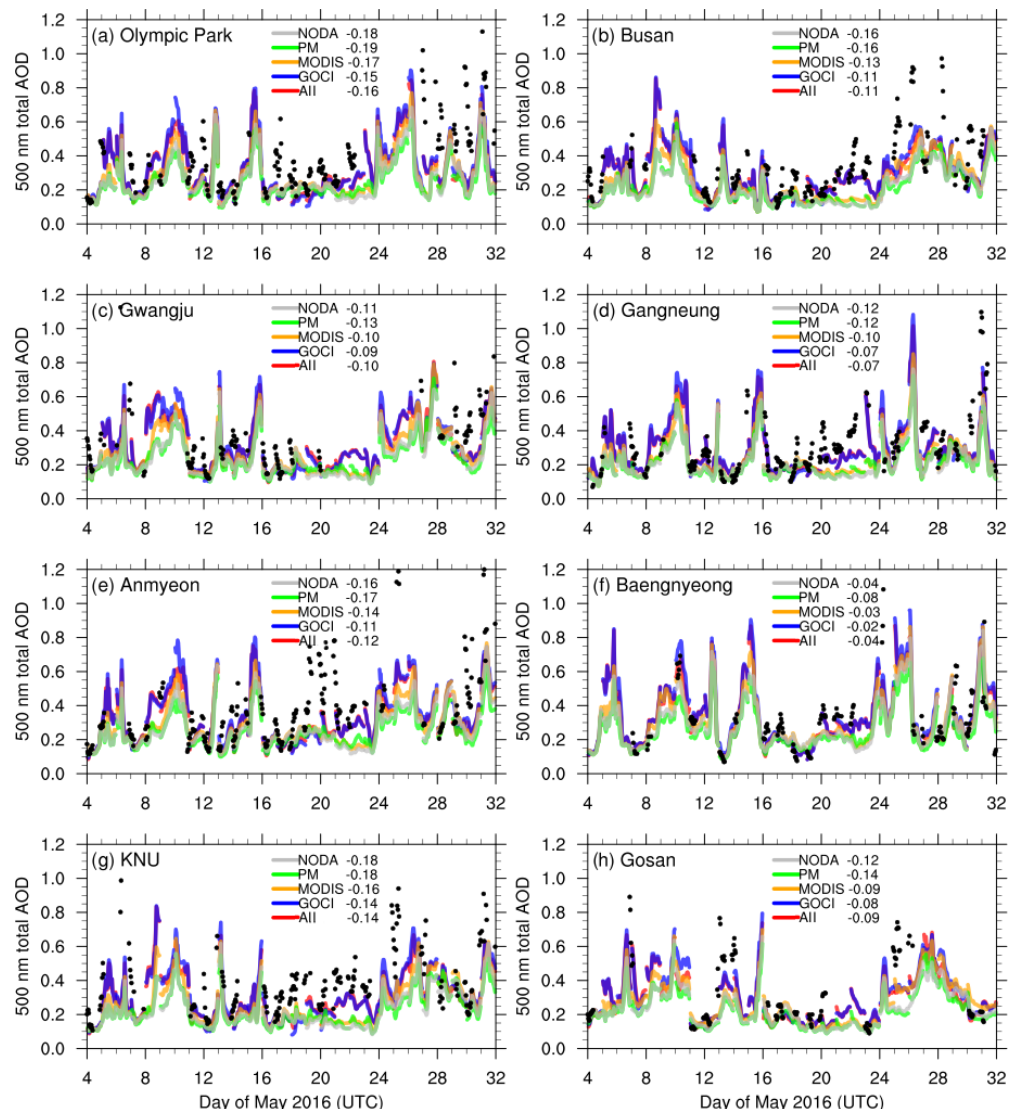
Figure 13. Hourly time series of total AOD at 500nm from 00:00UTC on 4 May to 23:00UTC on 31 May at eight different AERONET sites. Model values in different colors represent output every hour beginning at the initial time and ending at the 23rd hour of integration patched together for each 00:00UTC forecast. The bias (represented as f–o) averaged over the entire period is shown next to each experiment name. AERONET observations represent hourly averages as black